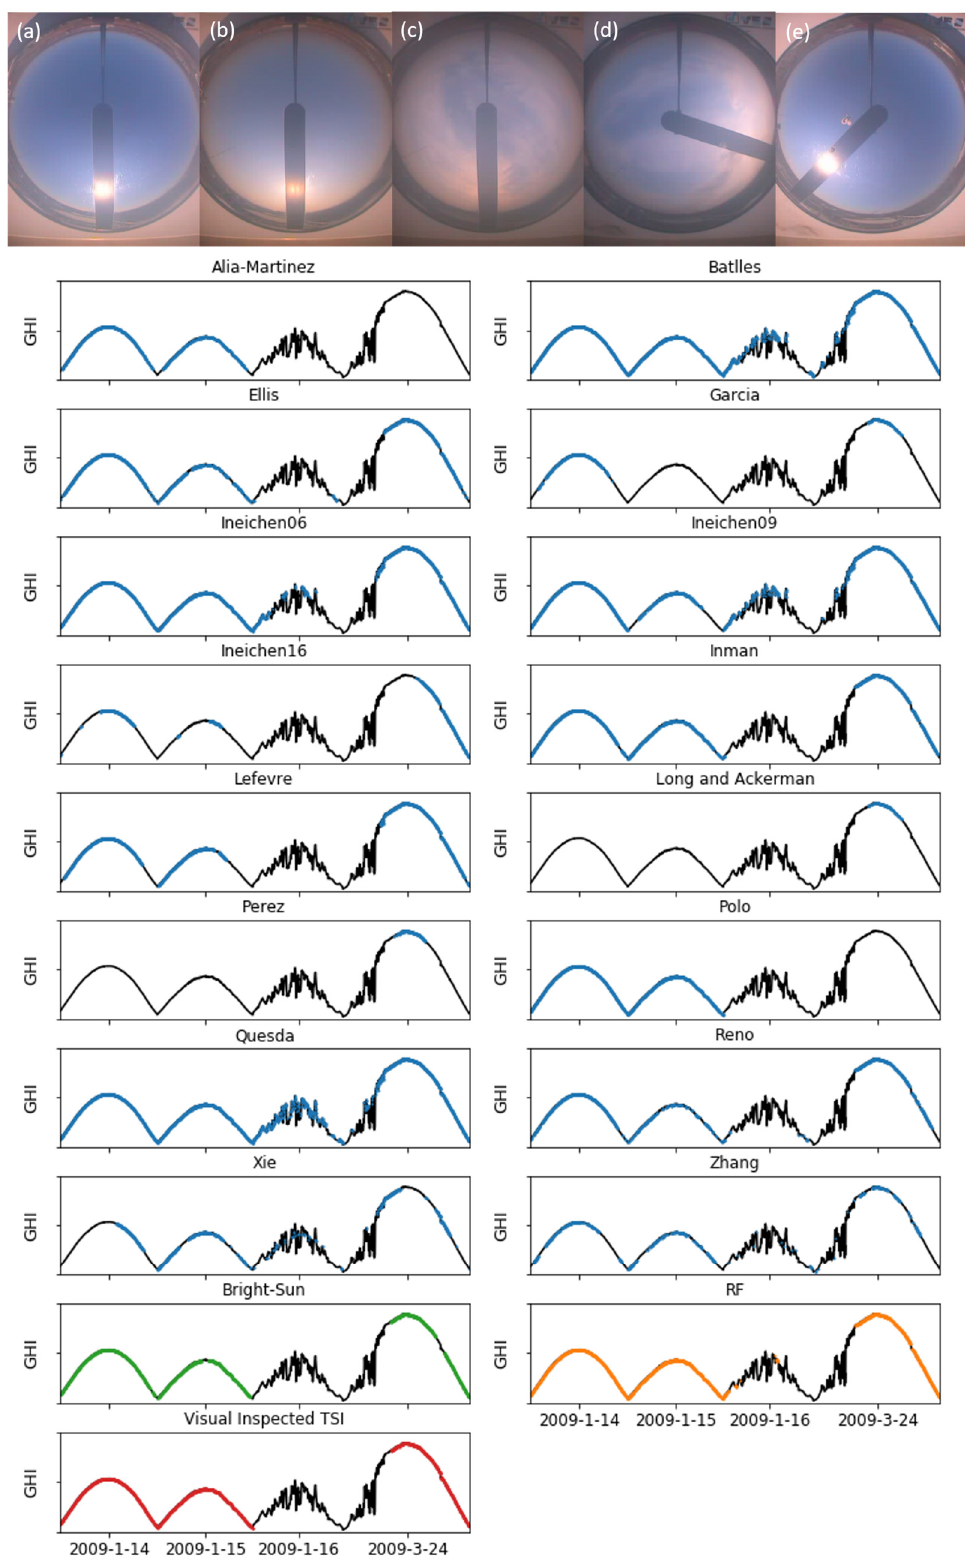
Figure 6. Four-day typical examples from TSI images: ( a ) clear and clean skies with AOD of 0.08 on 14 January 2009; ( b ) clear but polluted skies with AOD of 0.52 on 15 January 2009; ( c ) cloudy (cirrus) with AOD of 0.69 on 16 January; ( d , e ) cloudy in the morning but clear in the afternoon on 24 March 2009 (AOD = 0.14). CSD detection results for the four typical examples are attached. The panels in